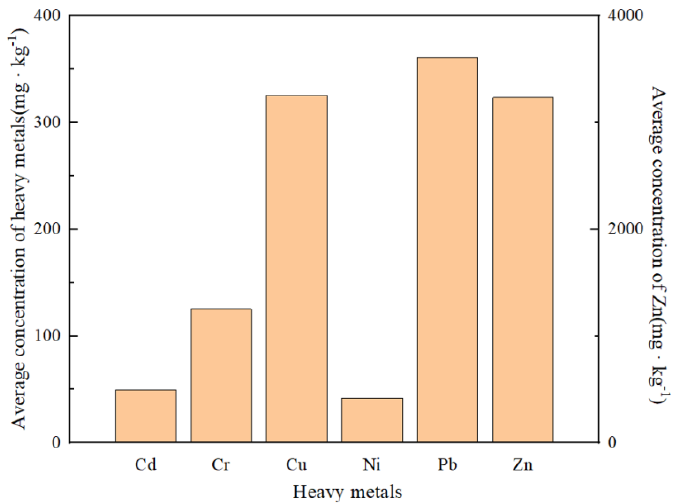
Figure 5. The average concentration of heavy metals over the last 20 years.